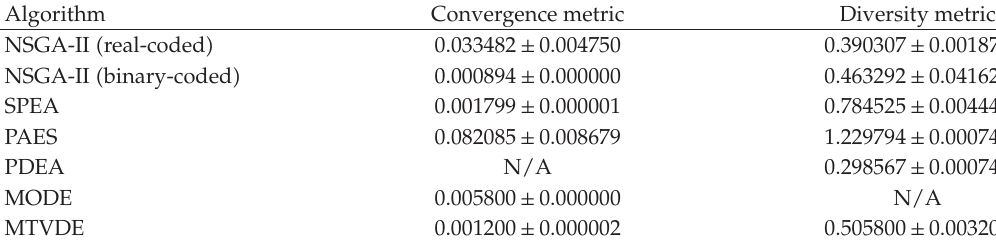
Table 1: Testing result’s statistics of the problem